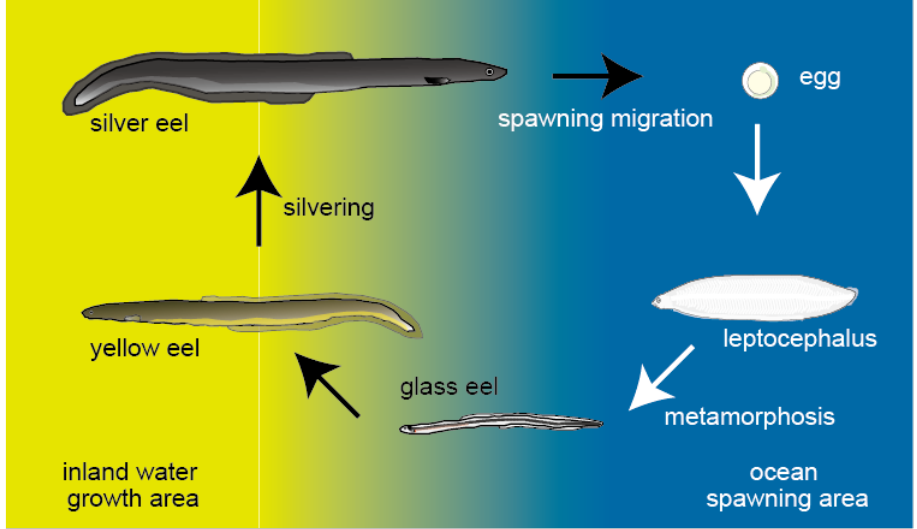
Figure 1. The anguillid eel catadromous life history with spawning and larval development occurring in the offshore ocean and juvenile growth occurring in freshwater or estuarine habitats.